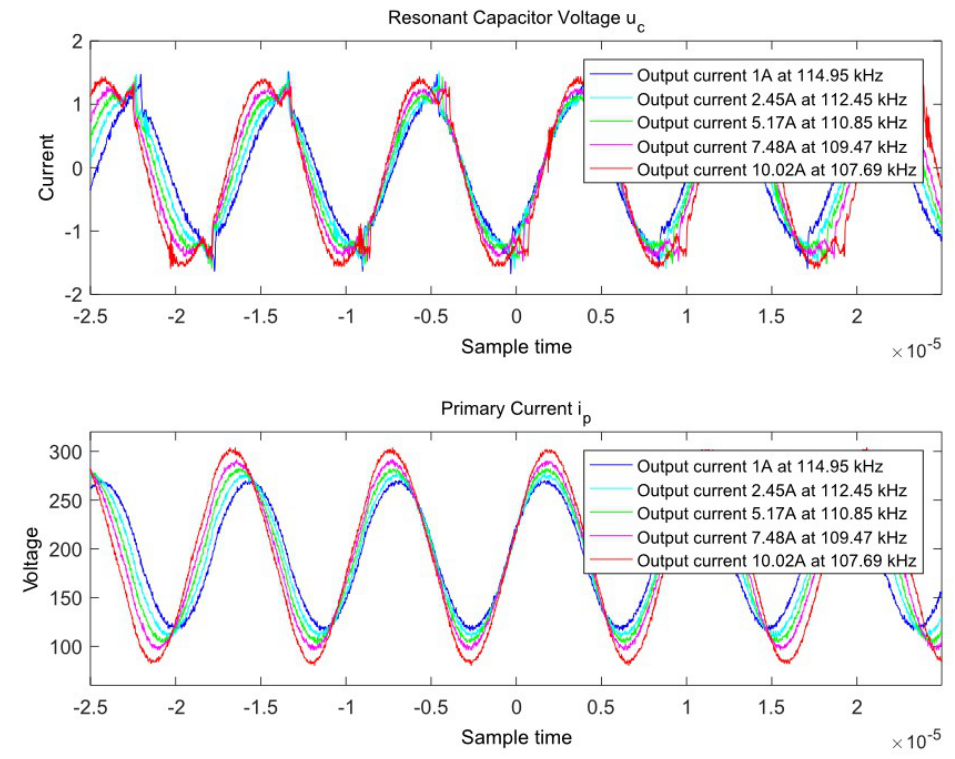
Figure 2. Measurements at five operating regimes, collected with a digital signal oscilloscope. Since the circuit is symmetrical, this is reflected by the switching function values of +1 and −1.